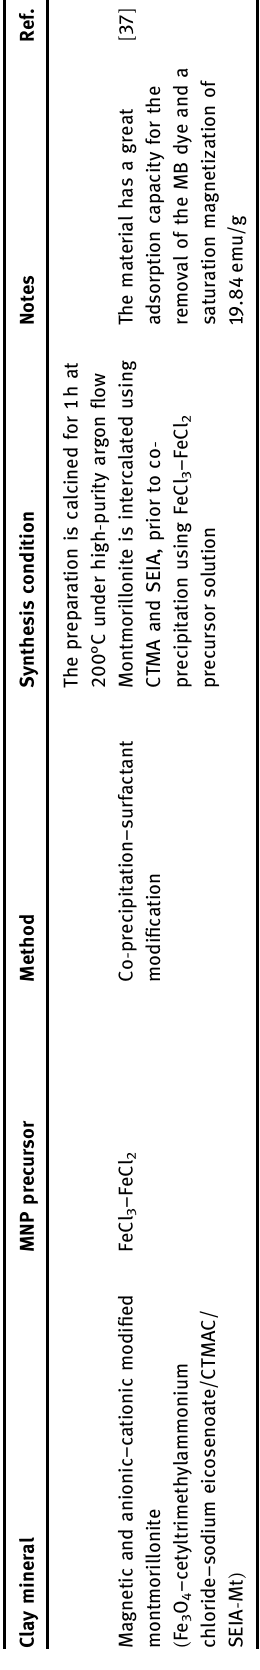
Figure 2: Schematic representation of the co -